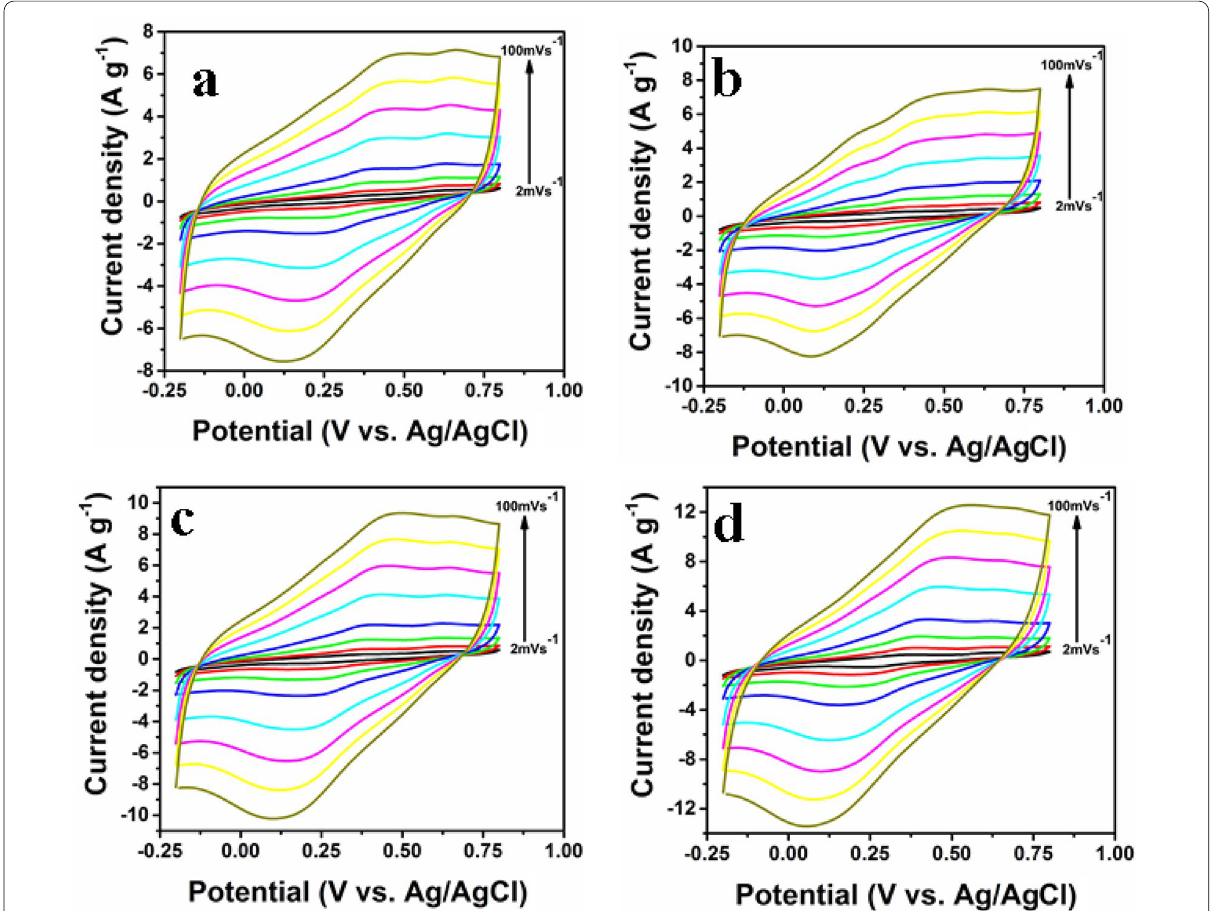
Fig. 5 CV curves of MB electrodes at different scan rates in the potential range of 0.4 mM MB and d 1.0 mM